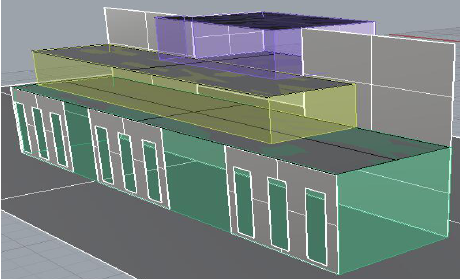
Figure 15. Top-bounded spaces and the corresponding navigation